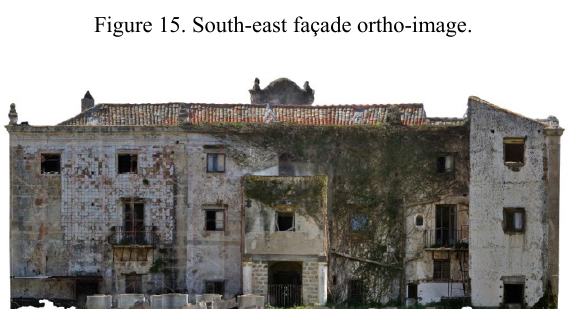
Figure 20. Map of significant damages on the south-east